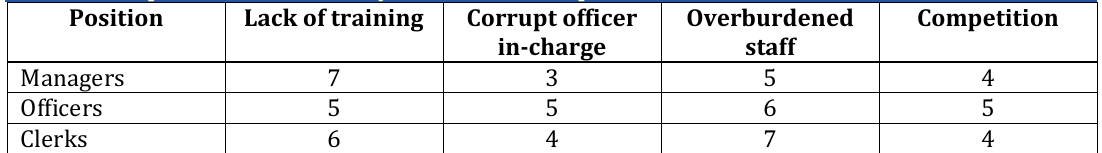
Table 9: Responses about the Key Reasons for Perpetration of Frauds in Banks Position Lack of training Corrupt officer